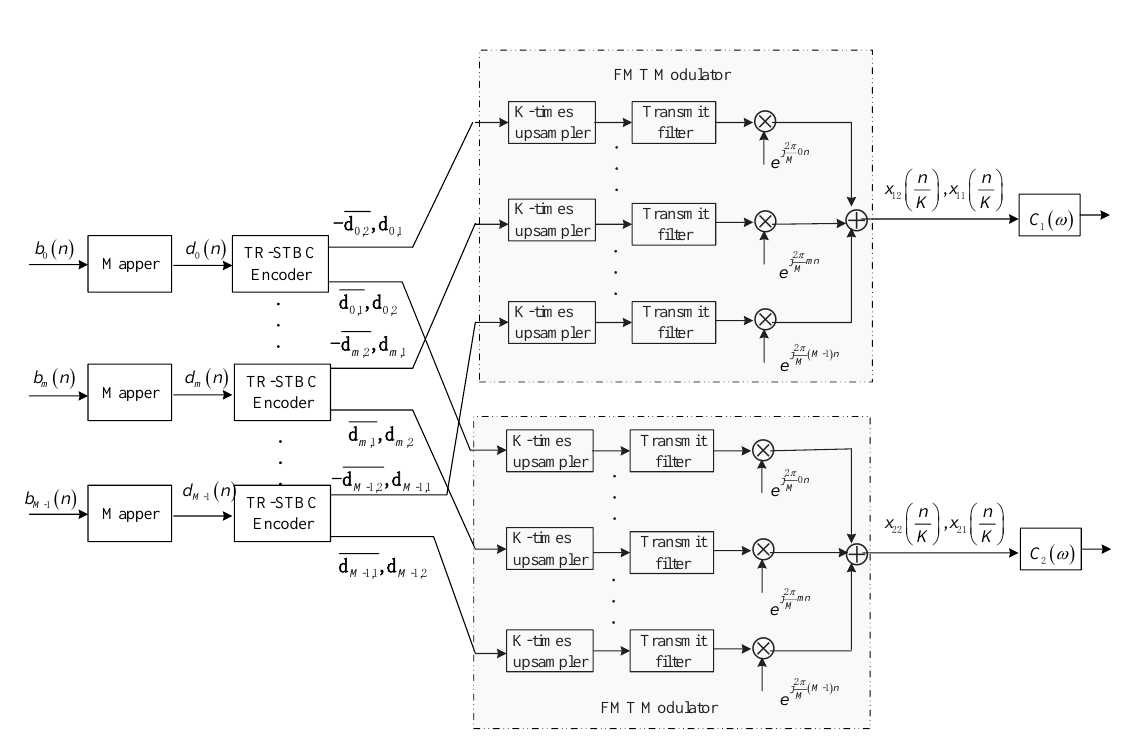
Figure 1. Block diagram for transmit structure.